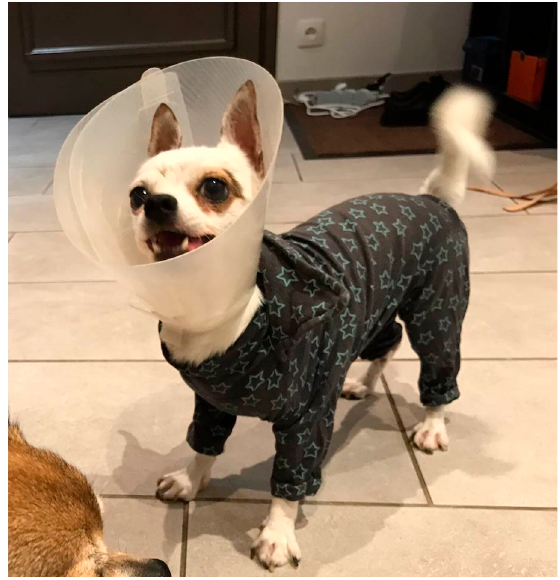
Figure 2. The dog lives continuously with a protective suit and an Elizabethan collar to prevent wound formation.